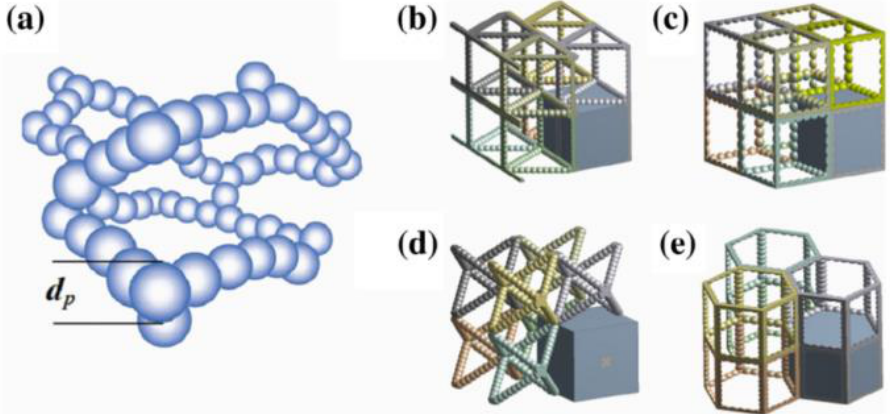
Figure 18. Schematic of base-catalyzed aerogel structures: ( a ) Aerogel backbone; ( b ) Regular triangular prism; ( c ) Cube; ( d ) Octahedron; ( e ) Regular hexagonal prism. In recent years, Fang et al. [78], Han et al. [79], Kan et al. [80], Qu et al. [9] and Ross- Jones et al. [81] used LBM to simulate the heat transfer of nano-porous geometric